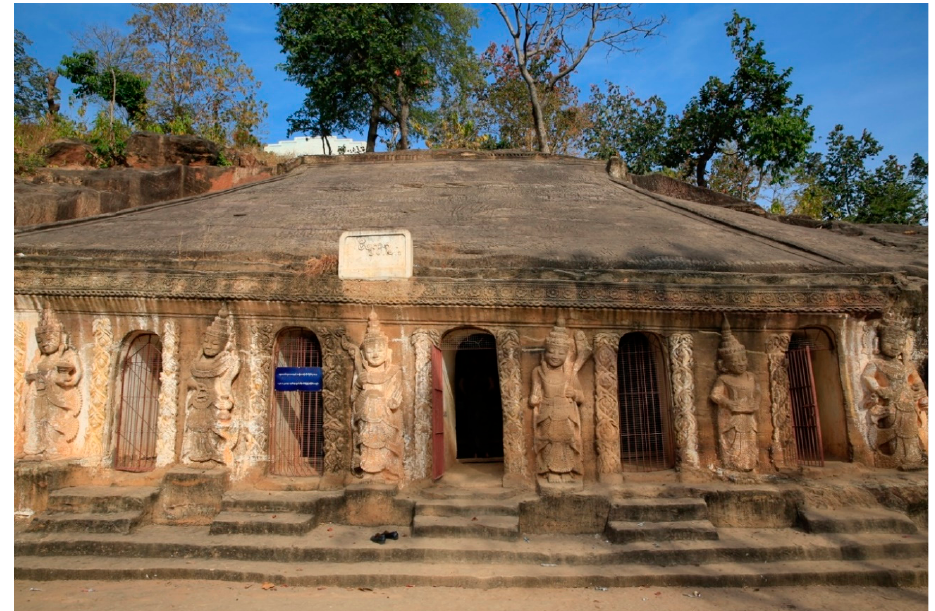
Figure 43. Powin Daung, cave 480 late 18th century. Décor preserving numerous inscribed punishments for specific transgressions.